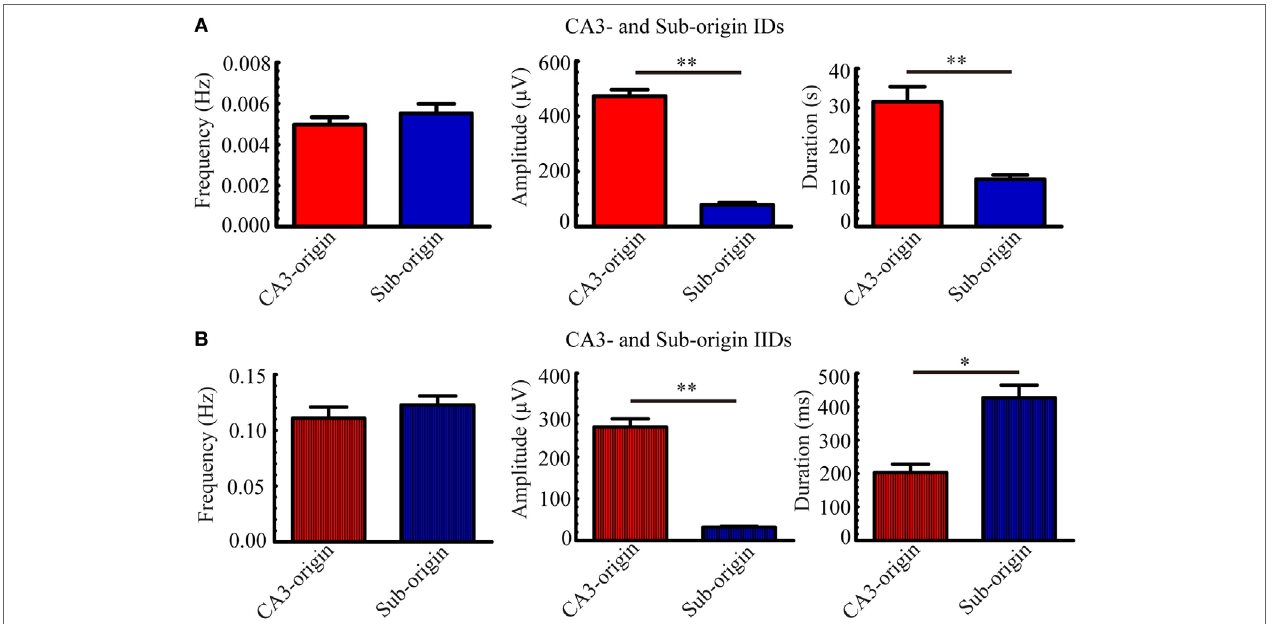
FigUre 4 | Parameters of ca3- and sub-origin ictal-like discharges (iDs)/interictal-like discharge (iiDs) . (a,B) The frequency, amplitude and duration of CA3- and Sub-origin IDs (a) and IIDs (B) . Data were presented as mean ± SEM. There was no significant difference between the frequencies of CA3- and Sub-origin IDs/IIDs ( P > 0.05, paired t -test, n = 21). The amplitude of CA3-origin epileptiform discharges in CA3 was significantly higher than that of the Sub-origin epileptiform discharges in the subiculum (** P < 0.01, paired t -test, n = 21). The duration of CA3-origin IDs was significantly longer than that of Sub-origin IDs (** P < 0.01, paired t -test, n = 21). The duration of CA3-origin IIDs was significantly shorter than that of the Sub-origin IIDs (* P < 0.05, paired t -test, n =